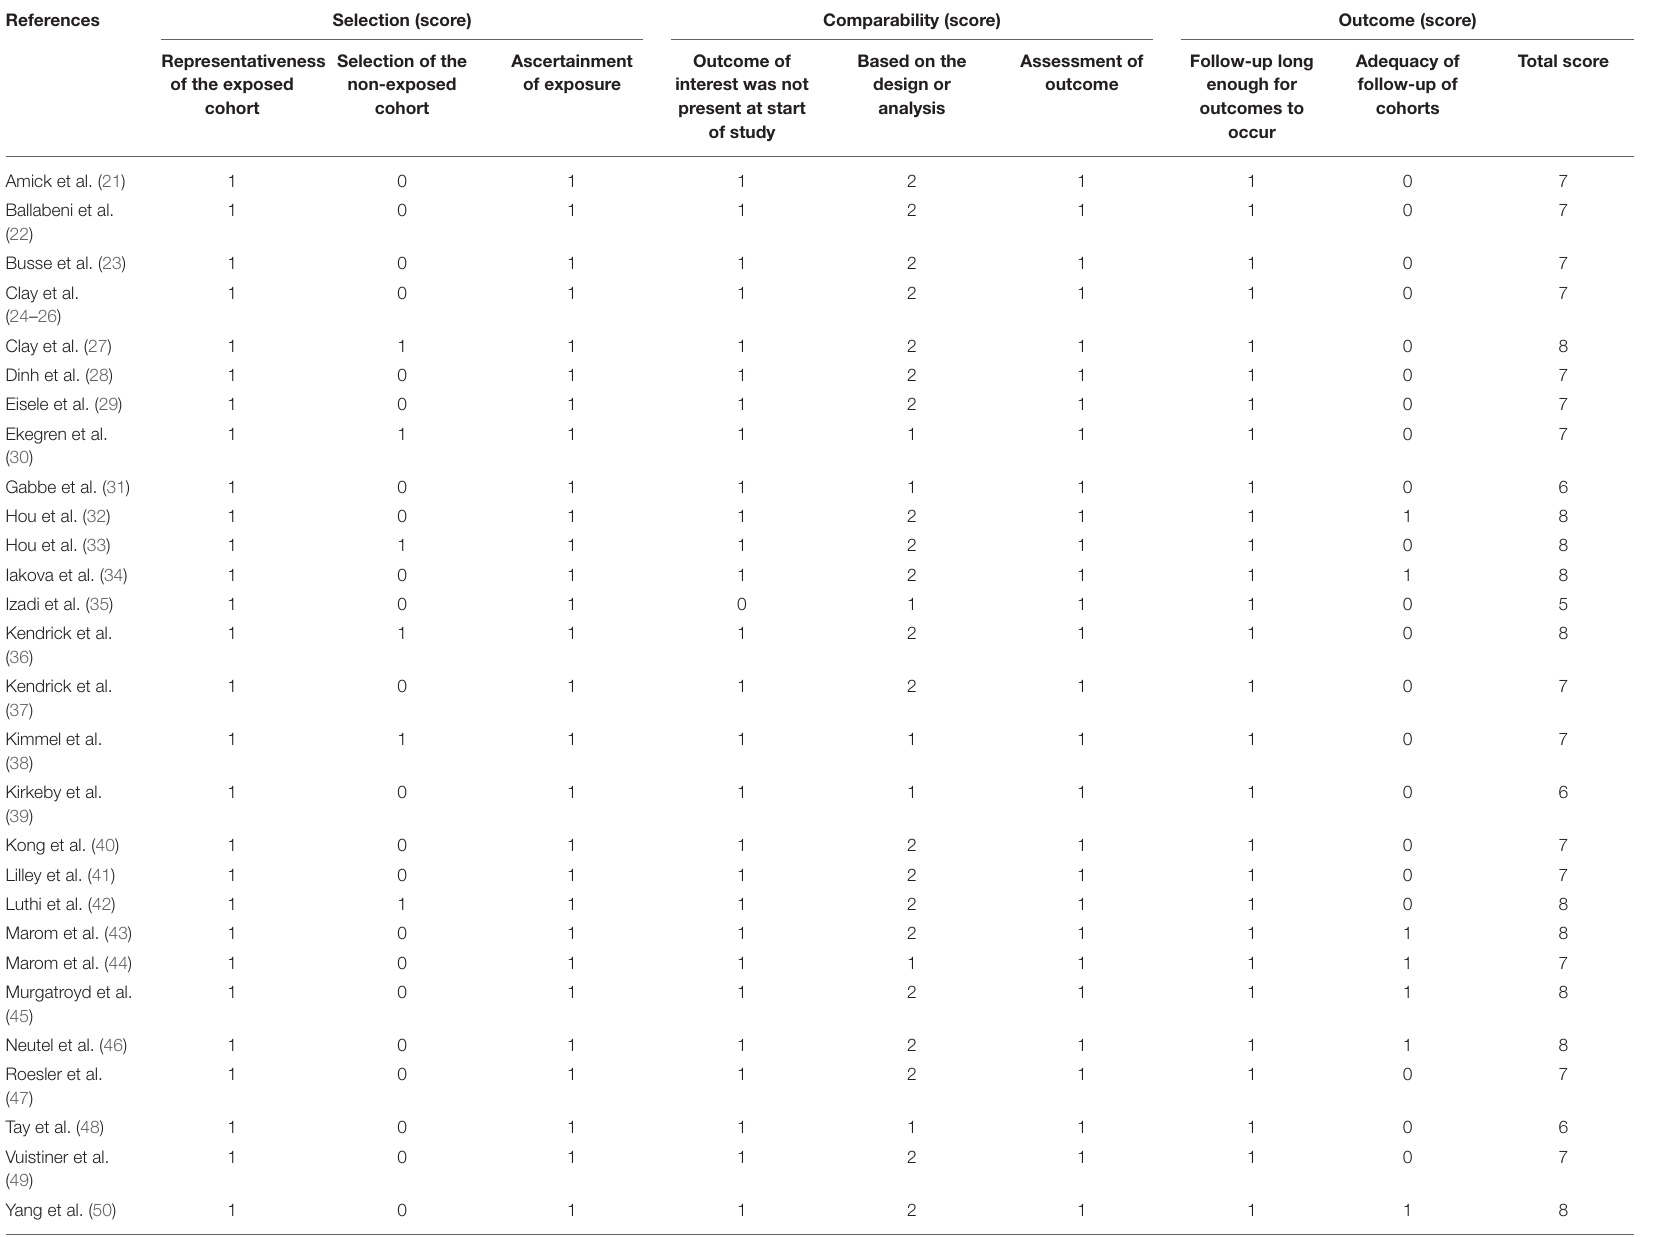
TABLE 2 | Quality assessment of included study based on the Newcastle-Ottawa